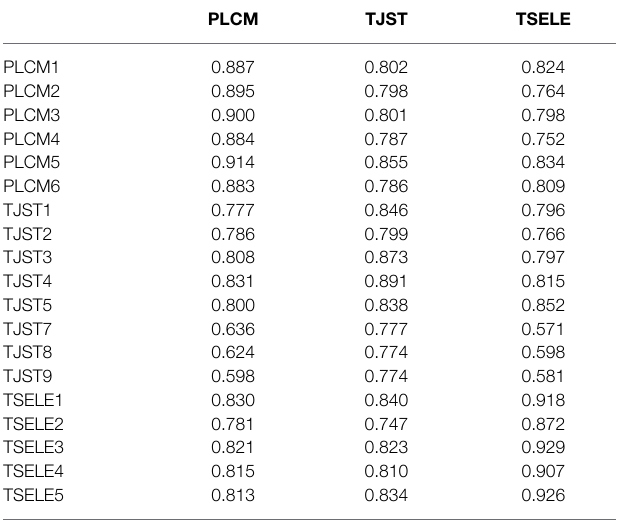
TABLE 2 | Reliability. Cronbach’s rho_A Composite alpha